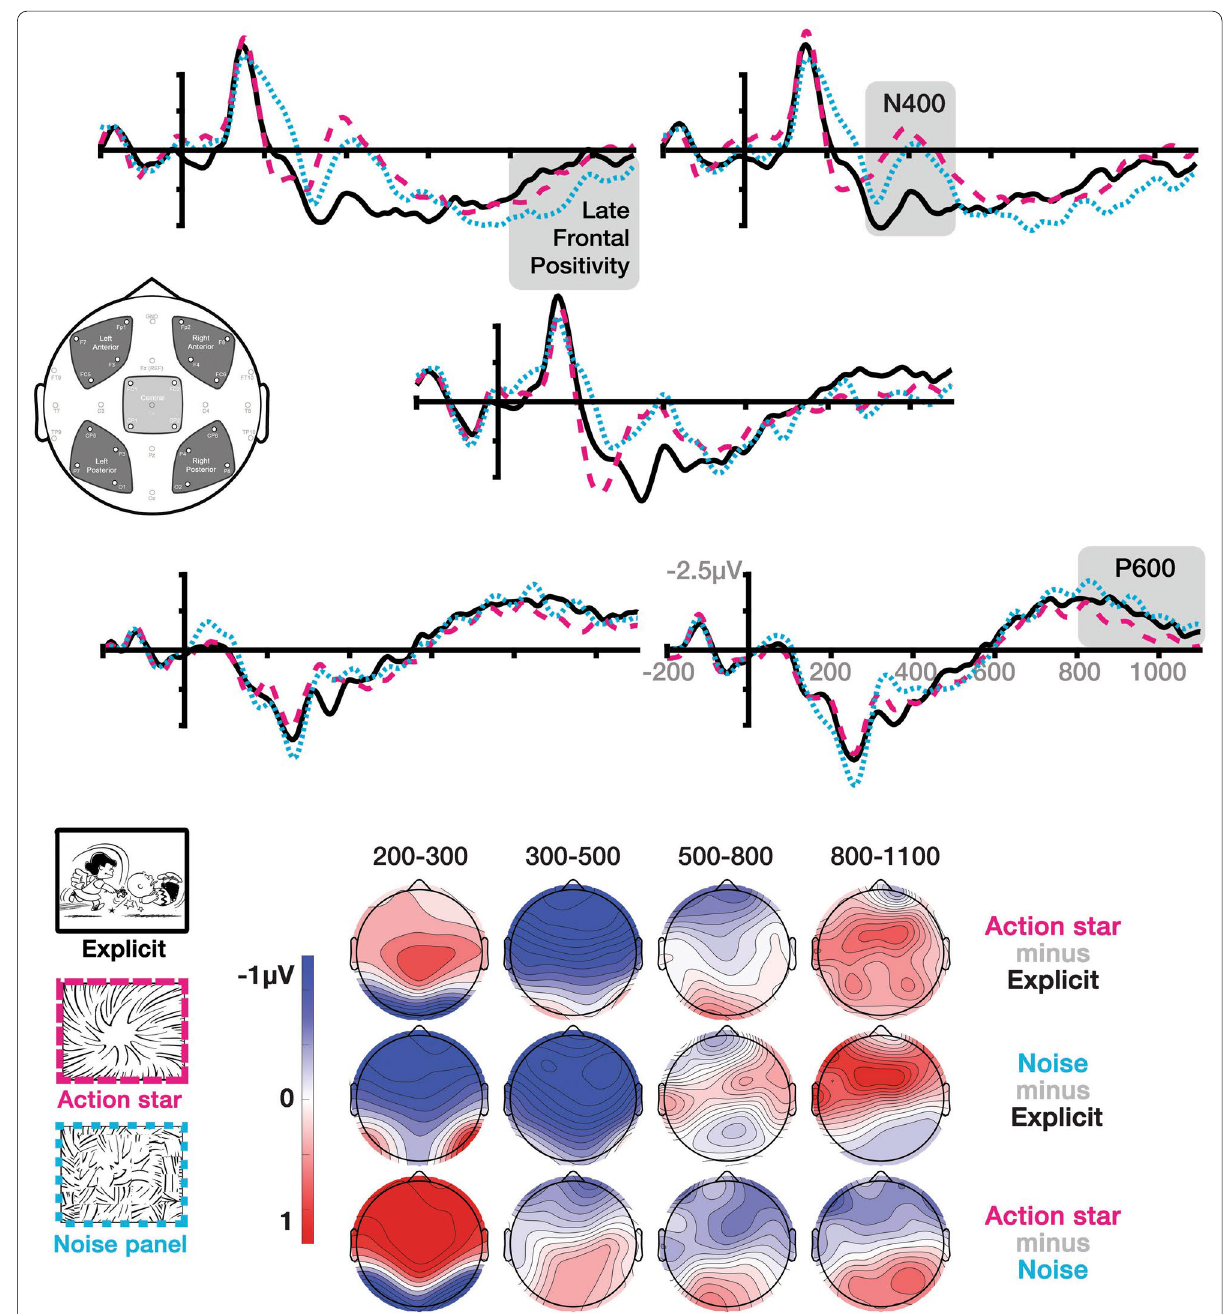
Fig. 3 ERPs time-locked to the critical panel of explicit event panels, action stars, and noise panels represented across electrodes and topographic maps. Highlights show analyzed epochs of the primary effects of the N400, P600, and Late Frontal Positivity. Negative is plotted